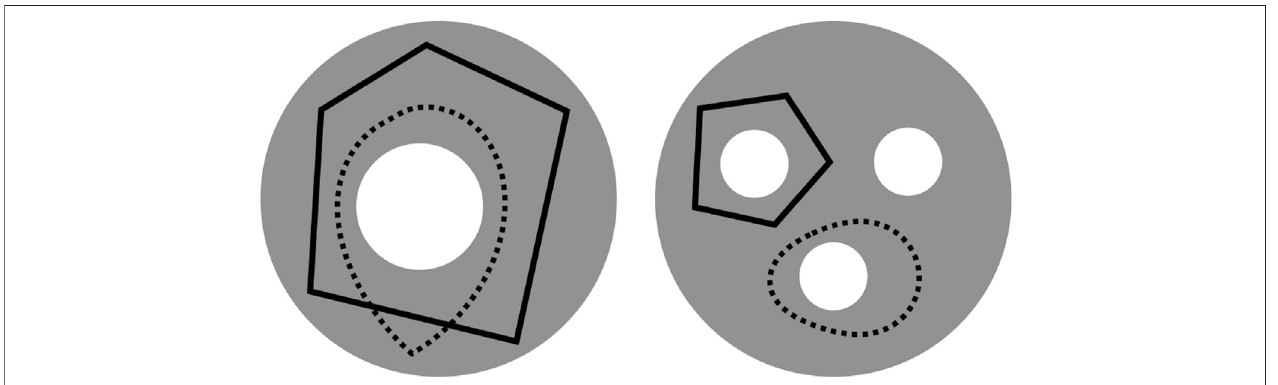
FIGURE 1 | Two disks (gray) — which we regard as 2-dimensional simplicial complexes, though the explicit decomposition into simplices is not shown — with different numbers of holes (white) and cycle representatives (black solid or dotted) adapted from (Carlsson, 2009). The disk on the left has a single 2-dimensional “ hole ” ( β (cid:2) 1 ) , and the two loops around itare cycle representatives for the same homology class. Similarly, the disk on the right has three “ holes ” ( β 1 shown are cycle representatives for different homology classes.